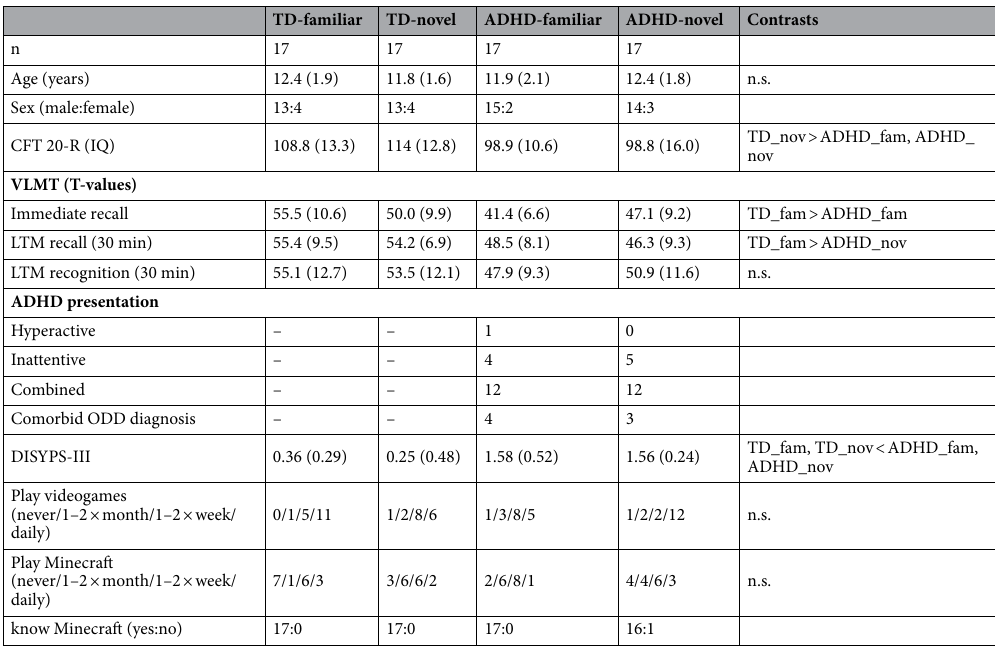
Table 1. Group characteristics. Data reflects sample after participant exclusion. If not specified otherwise, values represent either mean and standard deviation (in brackets) or counts. The parameters play videogames and play Minecraft represent the previous experience with videogames in general and Minecraft in particular. The parameter know Minecraft refers to how many children had at least seen someone else play the videogame before, and were thus familiar with its general appearance. To check for differences between groups, we computed a one-way ANOVA with the four groups ( TD-familiar, TD-novel, ADHD-familiar, ADHD-novel ) as the single factor. Significant contrasts show the results of Bonferroni or, in case of unequal variances, Games-Howell corrected post hoc tests. In case of ordinal data, we applied the Kruskal–Wallis test instead of an ANOVA. All tests were conducted with an alpha level of α = .05. Abbreviations: TD = Typically Developing, CFT = Culture Fair Intelligence Test, VLMT = Verbal Learning and Memory Test, ODD = oppositional